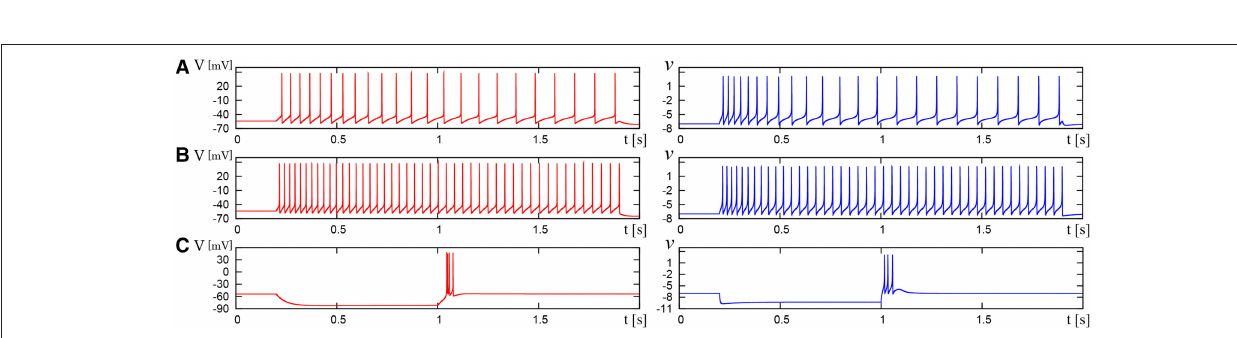
Frontiers in Neuroscience |